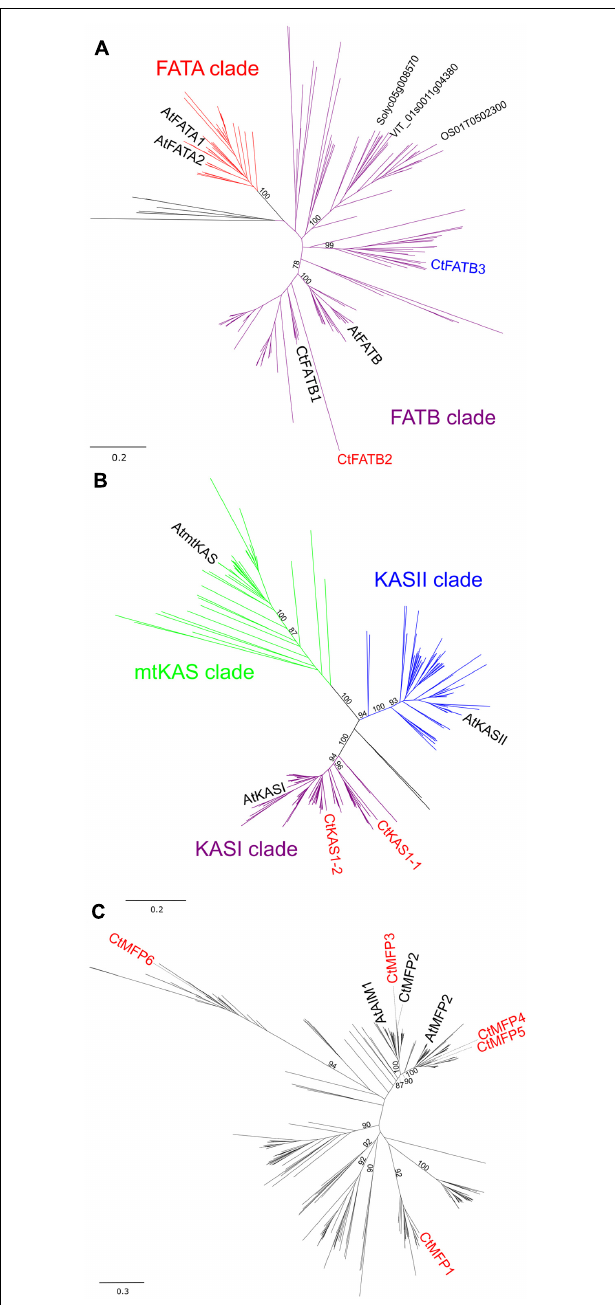
FIGURE 4 | Phylogenetic tree of selected full-length protein sequences of C. trapeziformis with protein sequences of 41 other plants including Arabidopsis thaliana . Neighbor-joining trees for (A) Acyl-ACP Thioesterase (FAT), (B) Ketoacyl-ACP Synthase (KAS), and (C) Multifunctional Protein gene families were constructed with 226, 257, and 370 sequences, respectively. Subgroups for FAT and KAS neighbor-joining trees were defined using both bootstrap values (1,000 replicates) and by the presence functionally characterized Arabidopsis thaliana proteins. Bootstrap values at critical branches differentiating the subgroups/clades are only shown and others removed for overall clarity. C. trapeziformis sequences colored in red depicts modulation (upregulated or downregulated) consistency in TC1 and TC2